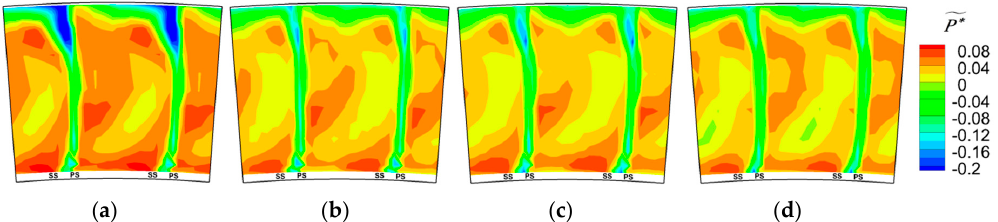
Figure 19. Total pressure of the stator outlet (test results). ( a ) Axisymmetric stator; ( b ) scheme s1 ; ( c ) scheme s2 ; ( d ) scheme s5.